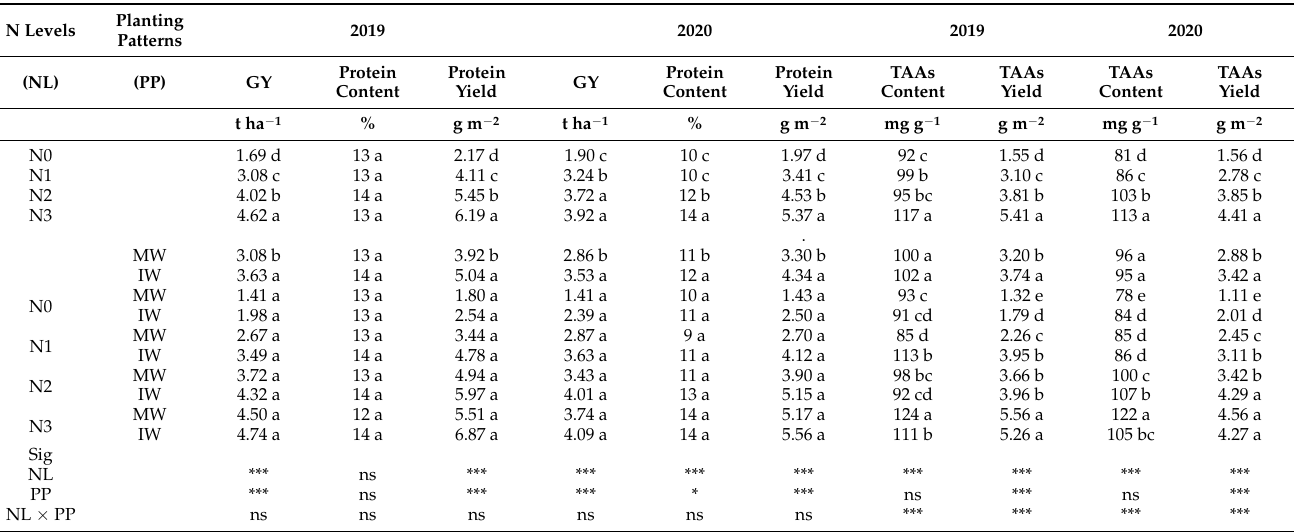
Table 1. The protein and total amino acids content and yield for inter- and mono-cropped wheat grain under different N